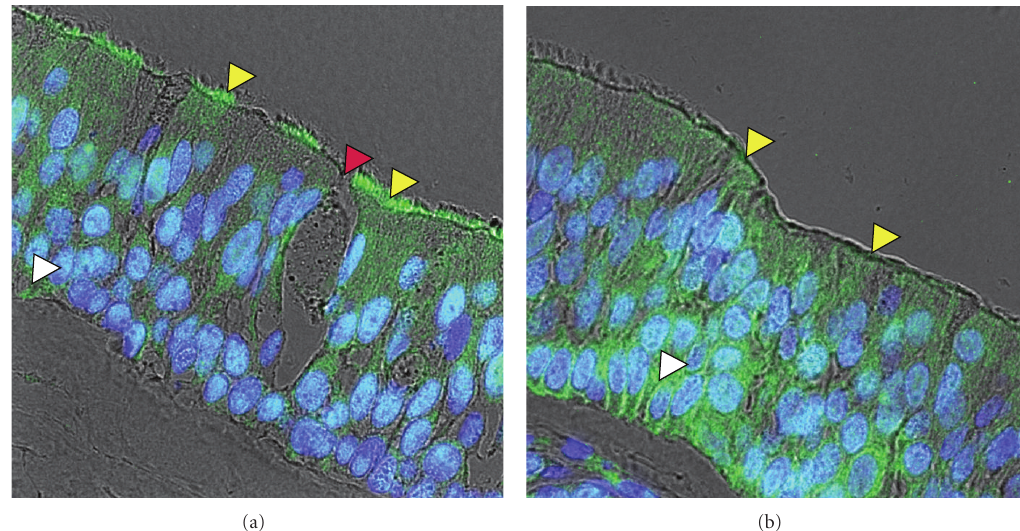
Figure 1: Receptors for minor group viruses are expressed in nasal epithelial cells. Para ffi n-embedded nasal tissue sections were prepared, rehydrated, and subsequently incubated with anti-LDLR [60] or anti-LRP1 [70] antibodies, followed by the respective fluorophore-labeled antichicken or antirabbit Alexa-488-IgG. Nuclei were stained with Hoechst dye. Pictures shown are overlays of immunofluorescence and phase contrast images. LDLR (a) and LRP1 (b) are present at the apical (yellow arrow heads) surface in ciliated as well as in basal cells (white arrow heads). A mucous secreting cell is indicated by a red arrow